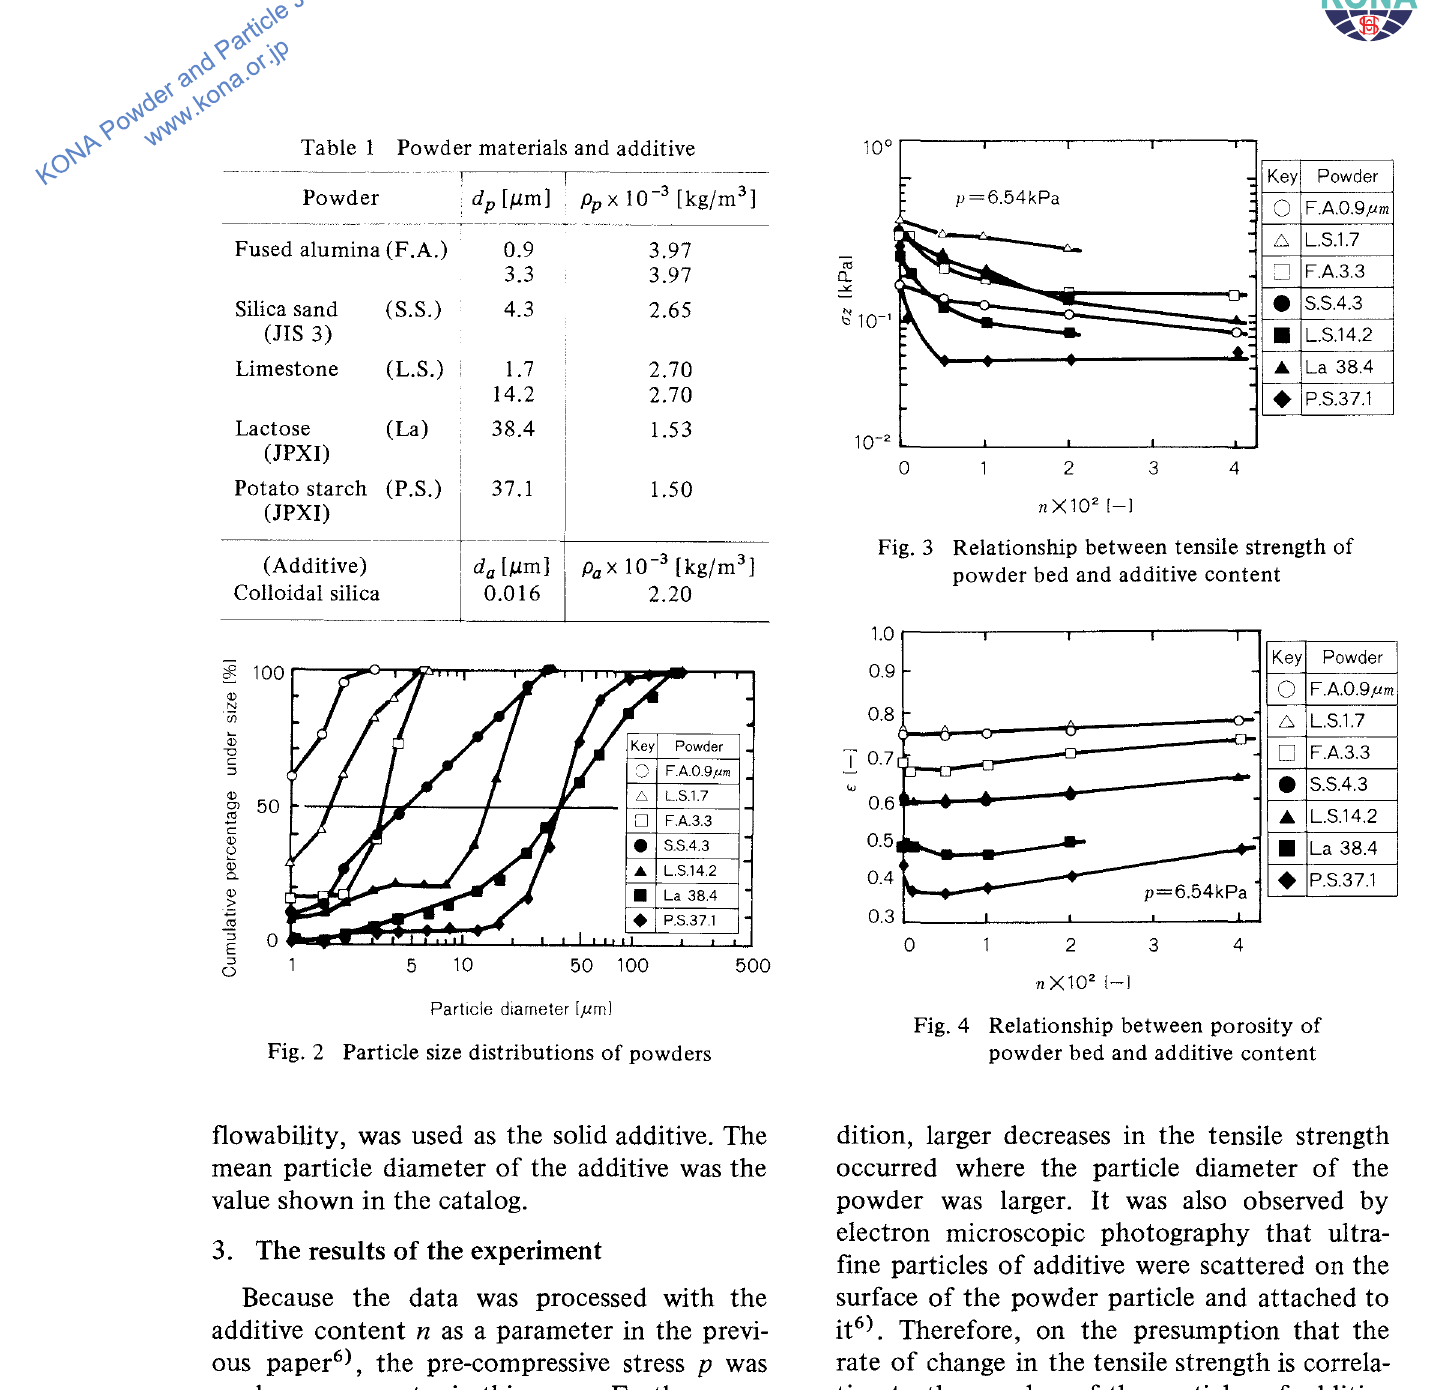
Fig. 2 Particle size distributions of powders